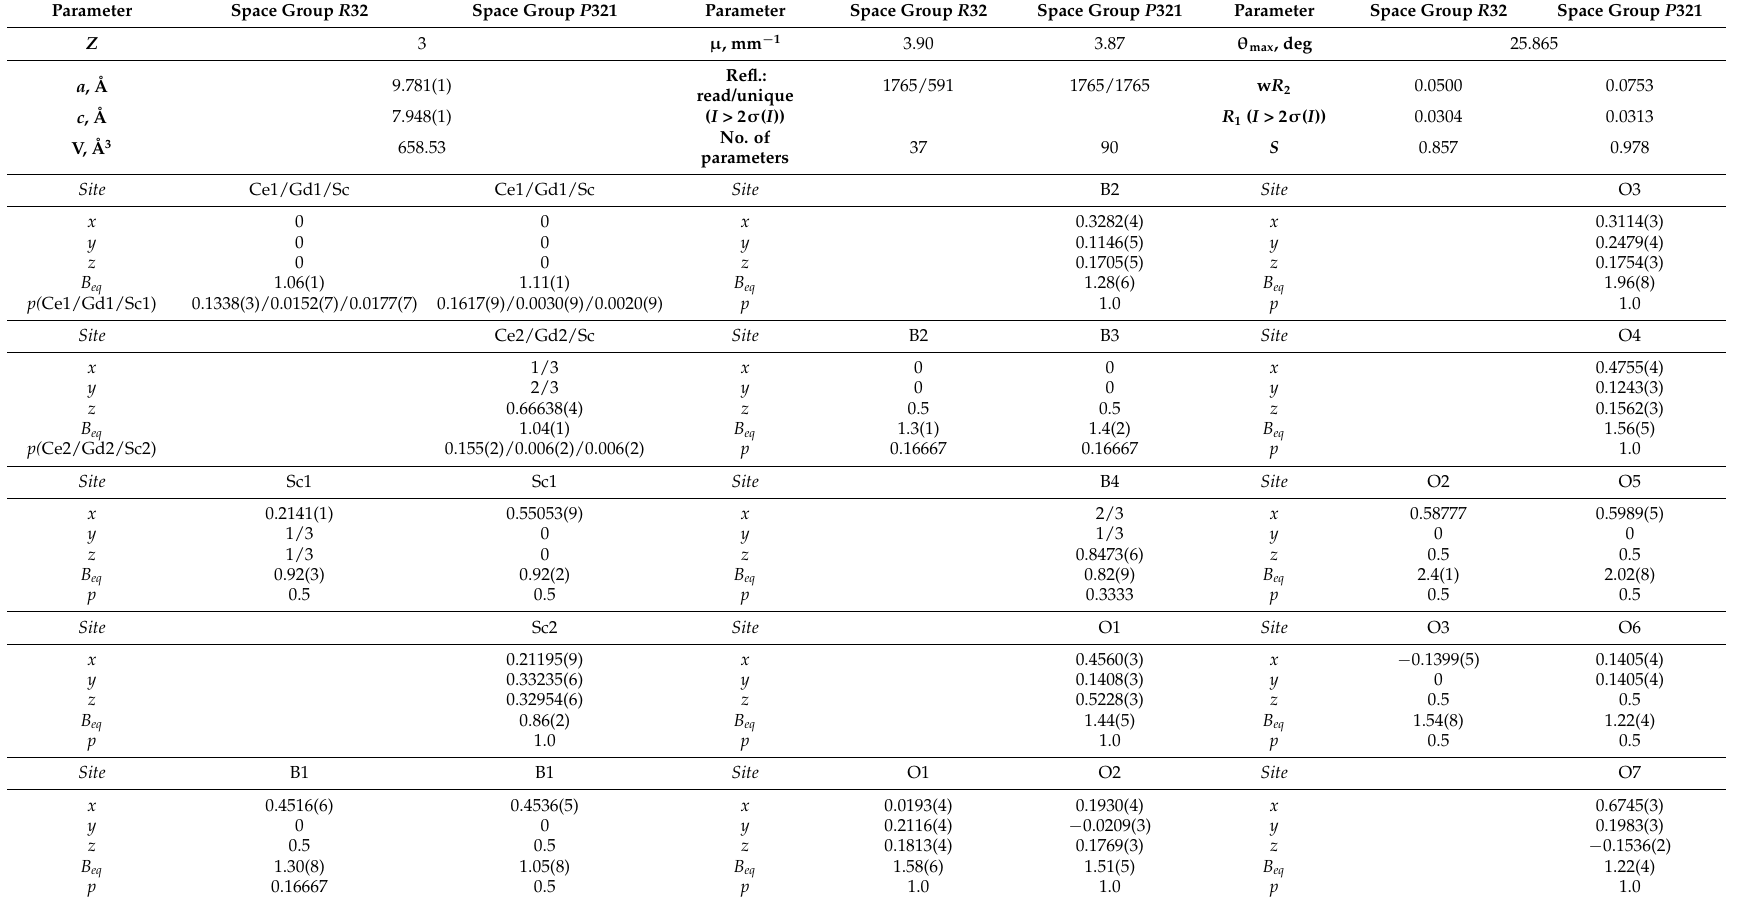
Table 3. Coordinates of atoms, atom displacement parameters ( B eq × 10 2 , Å 2 ), and site occupancies ( p ) in the structure of (Ce 0.80 Gd 0.20 )Sc 3 (BO 3 ) 4 solid solution in the space group R 32 and P 321 according to the XRD data (Ag K α